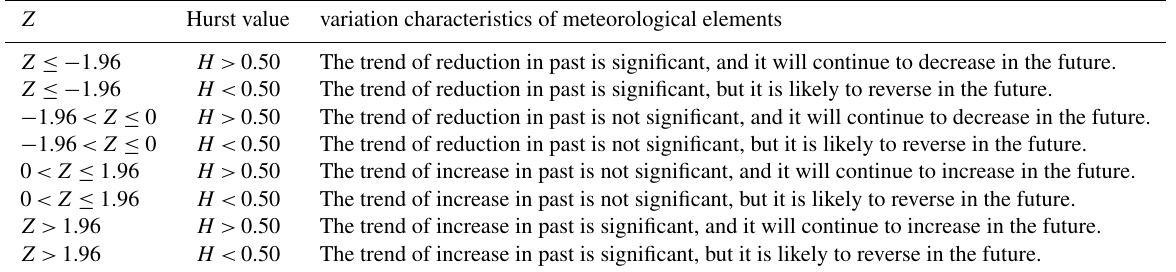
Table 2. Indicators set for determining the future change of regional meteorological elements. Z Hurst value variation characteristics of meteorological elements